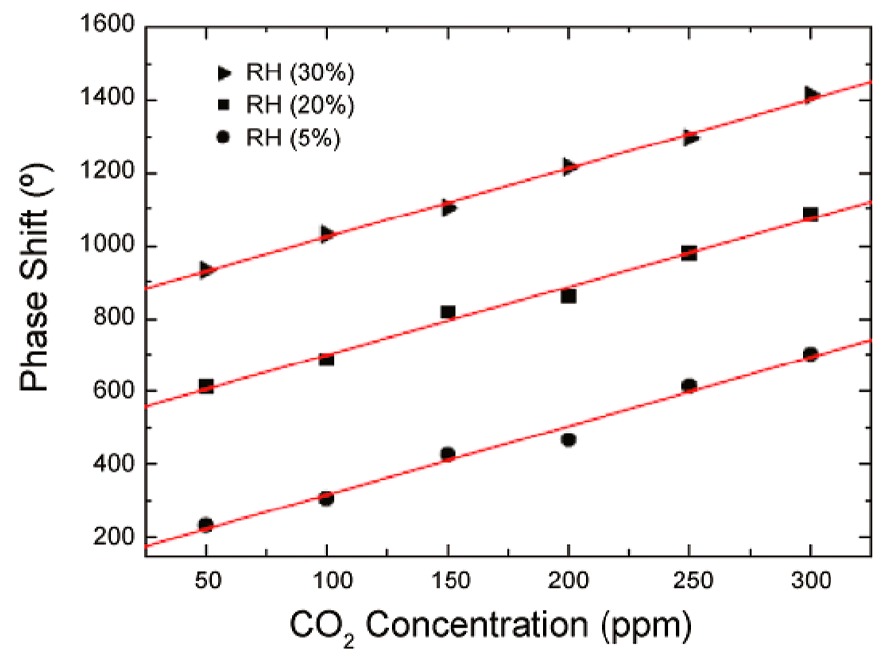
Figure 14. Phase shift observed as a function of carbon dioxide concentration at different water levels (RH: relative humidity). Reproduced with permission from Reference [48].